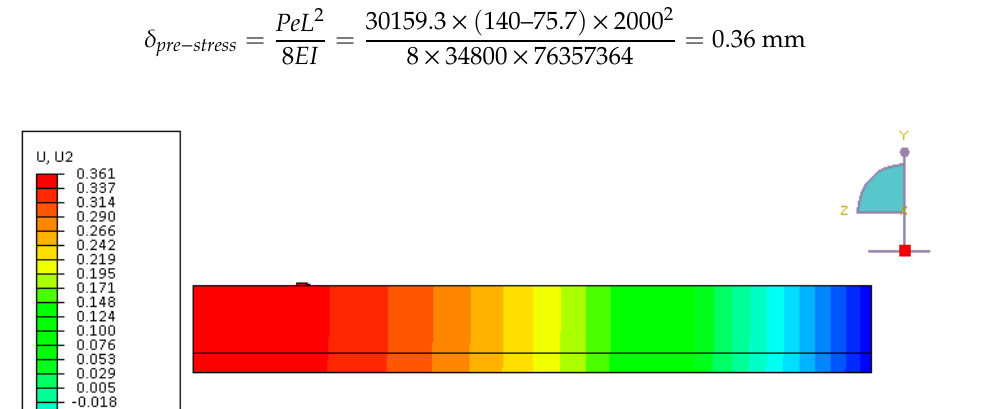
Figure 5. FE results for vertical displacement at the end of the pre-stressing step in ABAQUS.